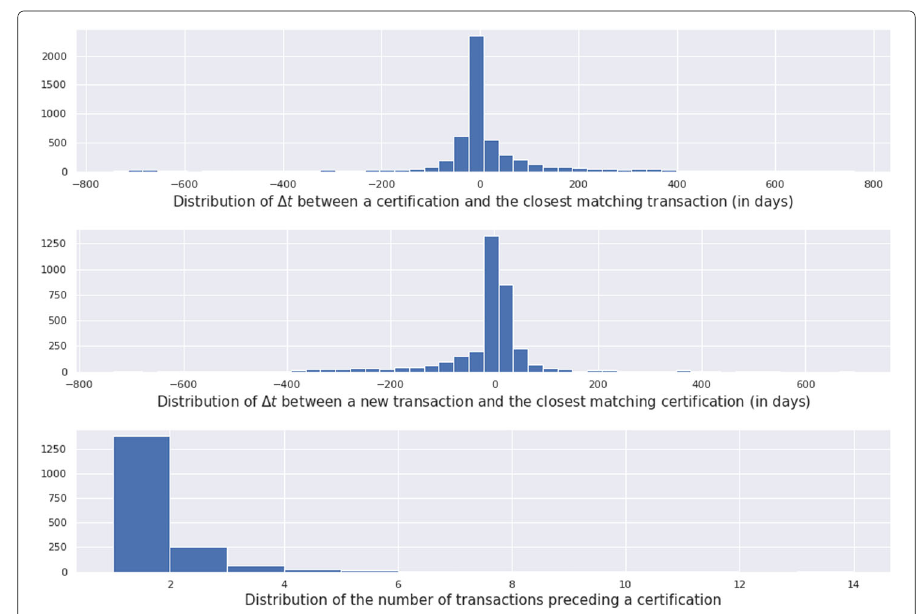
Fig. 7 Top - Distribution of time interval (cid:2) t (in days) between a certification in C and the closest matching transaction in T MM . Middle - Distribution of the time interval (cid:2) t (in days) between a new transaction in T MM (i.e. a transaction between two members who never made a transaction before) and the closest matching certification in C . Bottom - Distribution of the number of matching transactions in T MM preceding a certification in C for certifications occurring after prior transactions (in days) between a new transaction in T MM and the closest matching certification in C